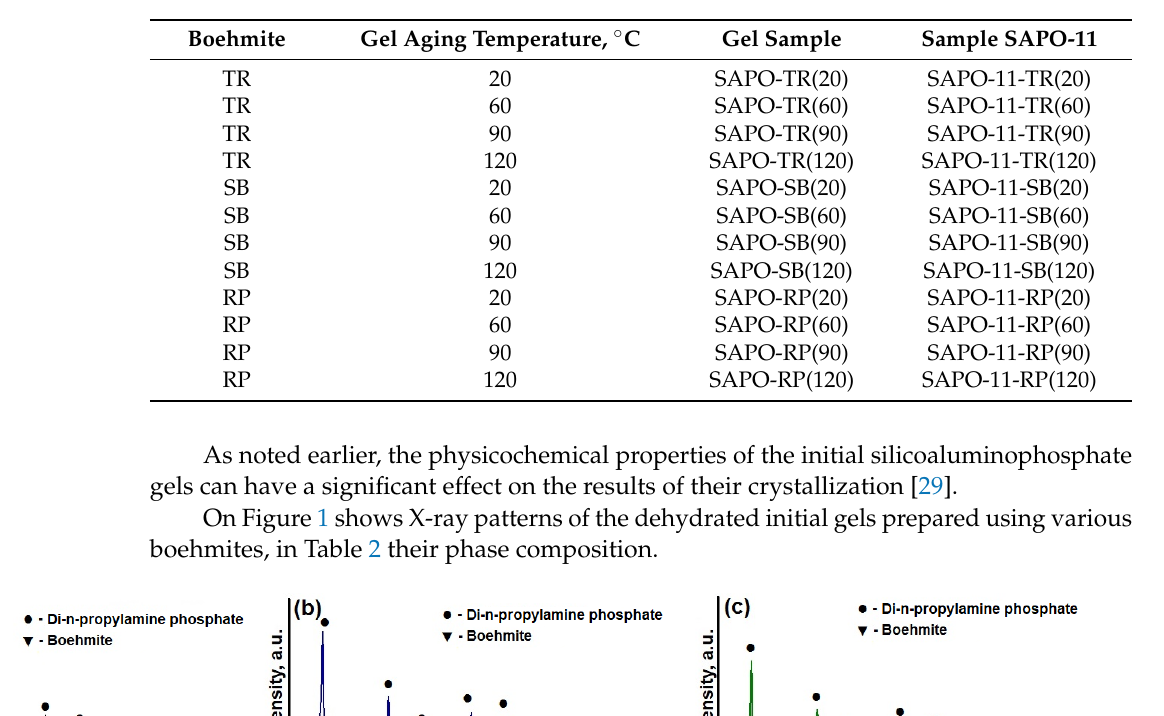
Table 1. Explanation of symbols silicoaluminophosphate gels and crystallization products based on them.